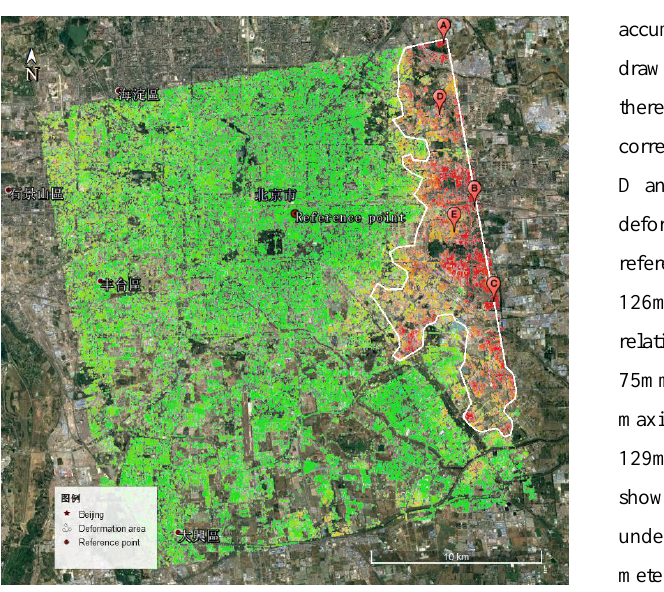
Figure 5. Surface deformation results